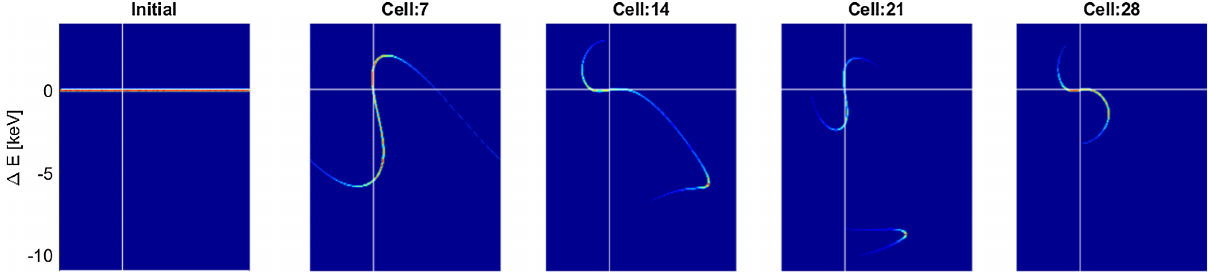
FIG. 14. Longitudinal phase space evolution for zero transverse emittance. The vertical axis is 0 < φ < 2 π .